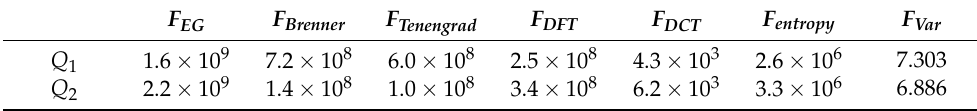
Table 2. Resolution vectors of two strips in Area